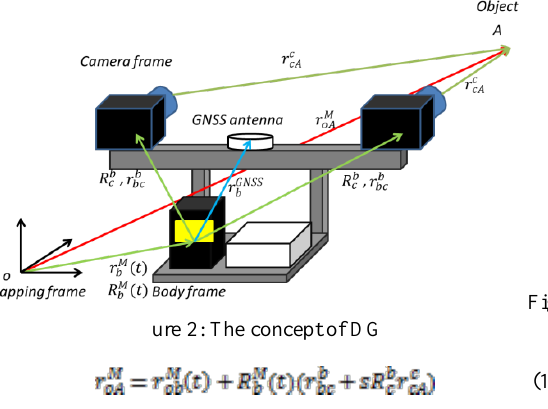
ure 2: The concept of